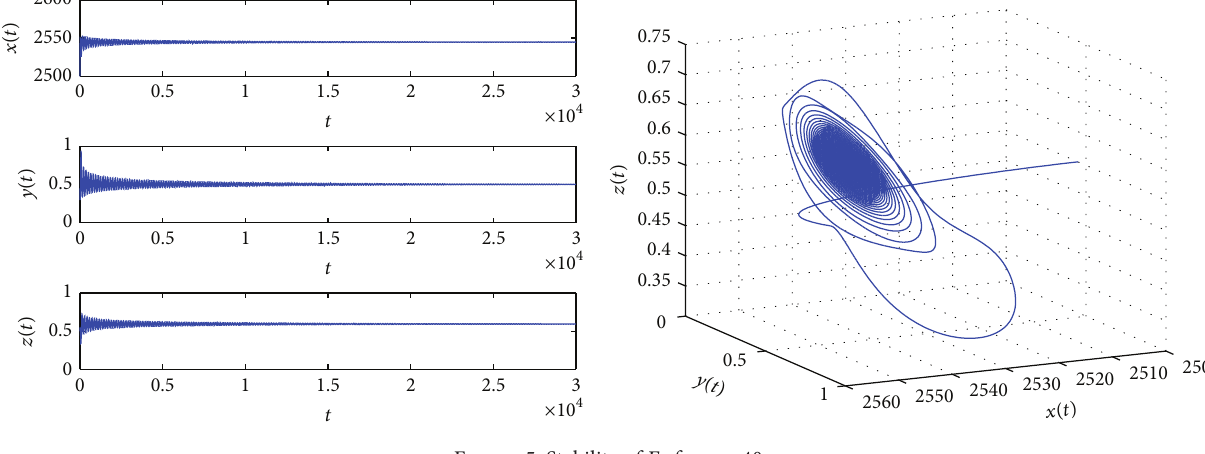
Figure 5: Stability of 𝐸 2 for 𝜏 = 40 .